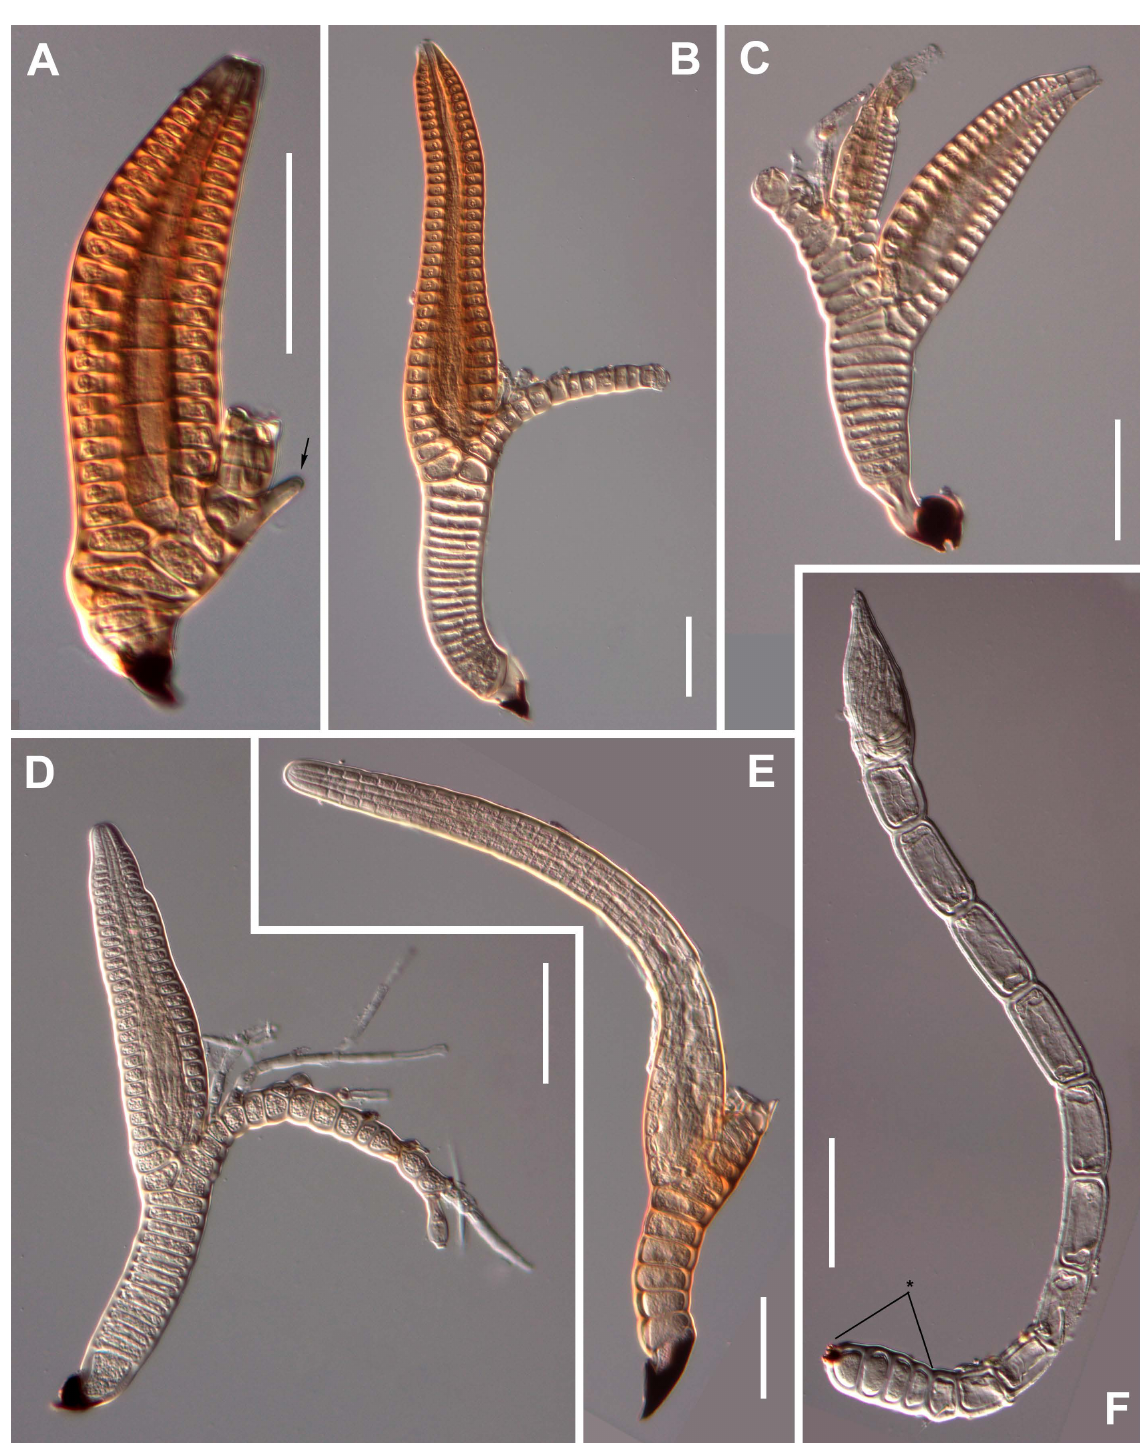
Fig. 3. A . Eusynaptomyces enochri Scheloske; reduced form showing the lateral outgrowth (arrow). – B – D . Eusynaptomyces hydrobii (T.Majewski) I.I.Tav.; mature thalli. – E . Rhynchophoromyces anacaenae Scheloske; mature thallus with broken appendage. – F . Thripomyces italicus Speg.; mature thallus showing the characteristic broadened cells at the base of the receptacle (*). Scale bars: 50 µm. Photographs from slides ZMUC C-F-122569 (A), ZMUC C-F-123552 (B–D), ZMUC C-F-123749 (E), and ZMUC C-F- 122983